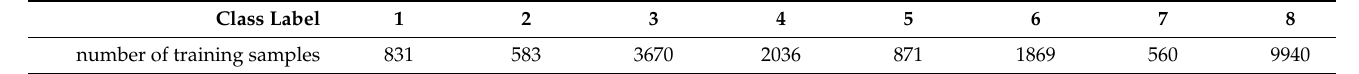
Table 3. The number of training samples for our test region is roughly